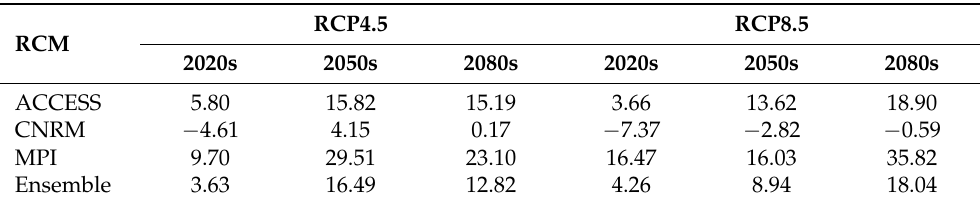
Table 4. Change in precipitation (%) for three different time-lines and RCMs under RCP4.5 and RCP8.5 scenario compared to baseline period of 1980–2020 for Nilwala catchment. RCP4.5 RCM